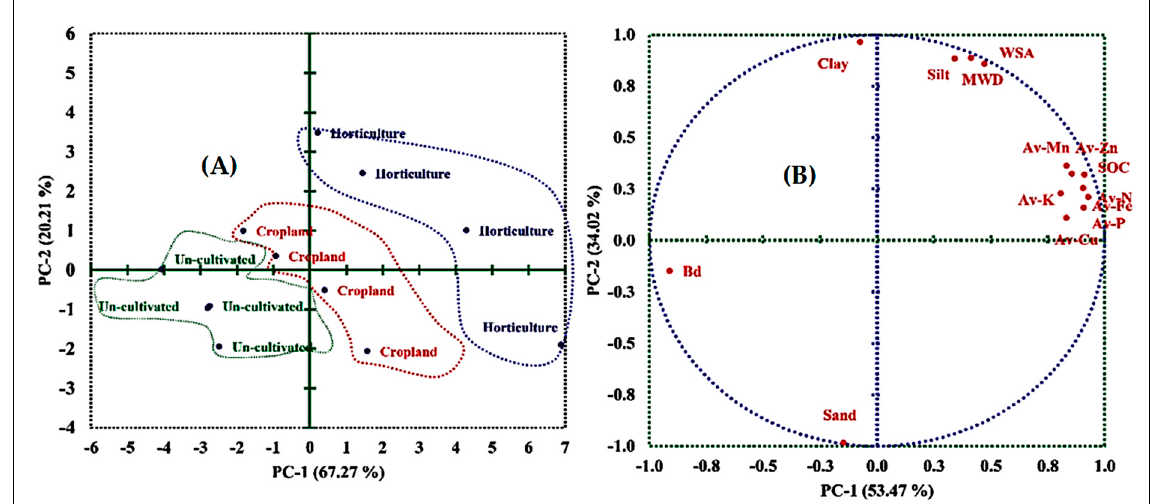
Figure 4. Principle component analysis (PCA) biplots on the land-use systems ( A ) and the different soil parameters including sand, silt, clay, bulk density (Bd), water-stable aggregates (WSA), mean weight diameter (MWD), soil organic C (SOC), available nitrogen (Av-N), available phosphorus (Av-P), available potassium (Av-K), available zinc (Av-Zn), available-copper (Av-Cu), available iron (Av-Fe) and available manganese (Av-Mn) ( B ).